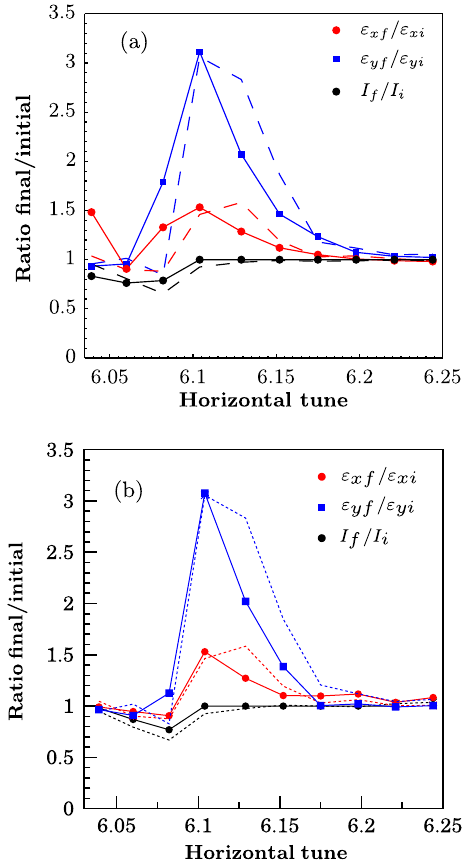
FIG. 5. (a) Emittance growth and beam survival as com- puted with MAD-X (adaptive mode). (b) Simulation results with MICROMAP (frozen mode). The quantities retrieved from the experimental data are shown with dashed lines in both cases.